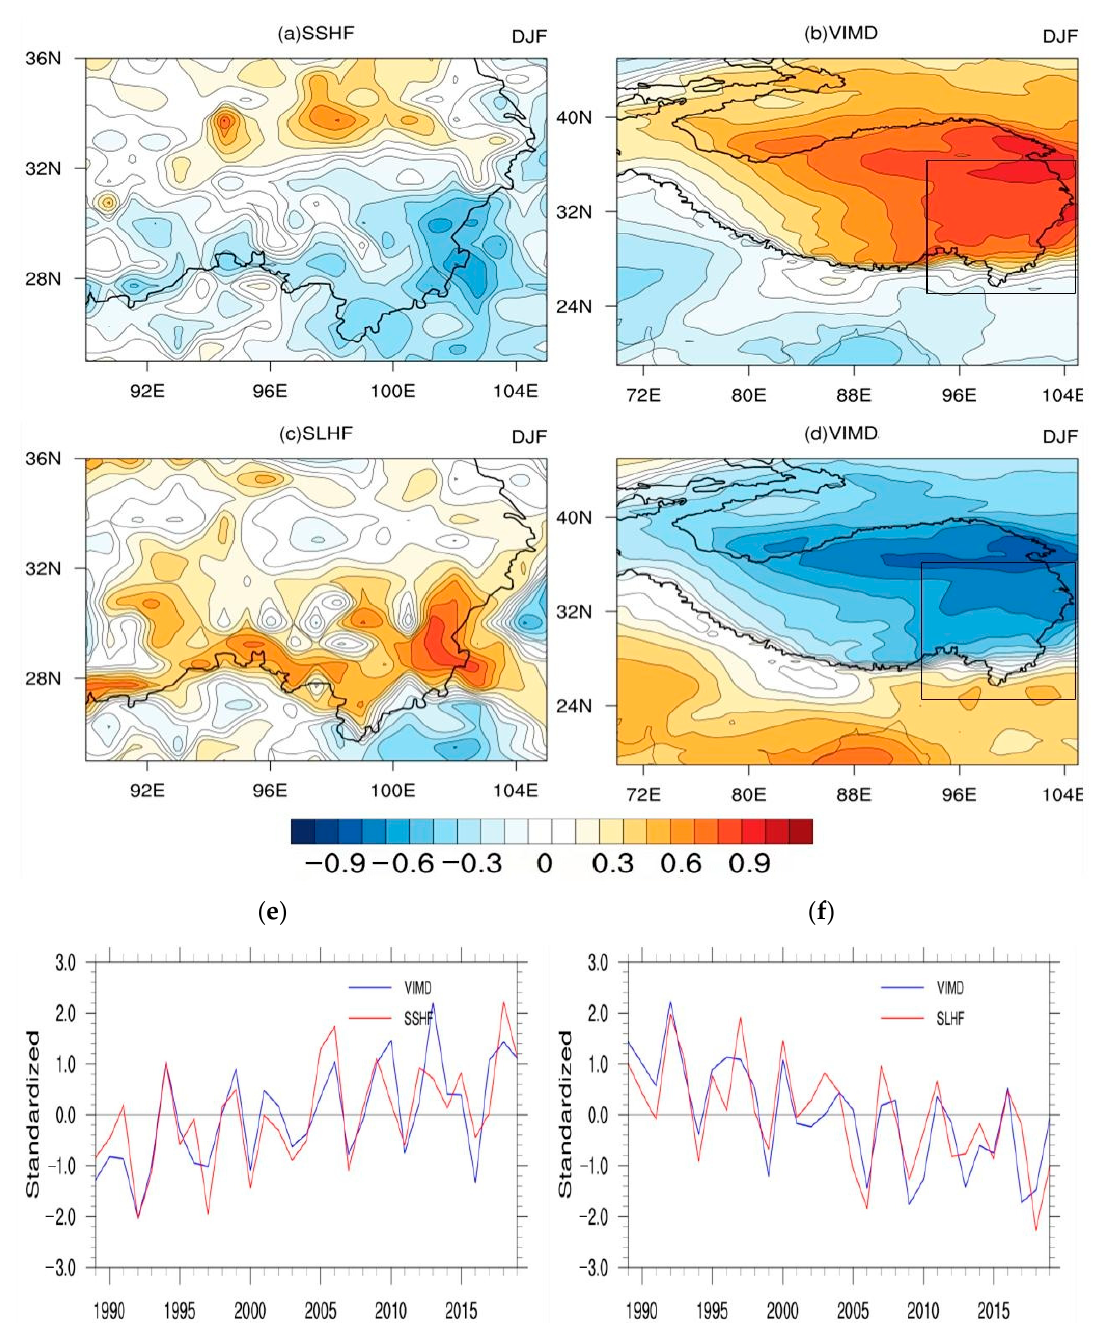
Figure 10. ( a – d ) SVD analysis and ( e , f ) corresponding time series of the surface flux field and eastward water vapor flux field in southeastern Tibet during the non-AMS. ( a ) the first mode of the thermal field; ( b ) the first mode of the eastward water vapor flux field; ( c ) the first mode of the latent heat field; ( d ) the first mode of the eastward water vapor flux field; ( e ) the sensible heat flux and eastward water vapor flux field; and ( f ) the latent heat flux and eastward water vapor flux field. The solid black line is the boundary of the Tibetan Plateau in ( a – d ). The solid red line is SSHF time series and the solid blue line is VIMD in ( e , f ) time series.